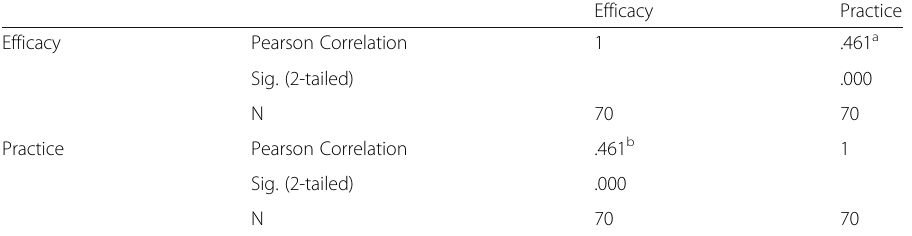
Table 2 Pearson Correlation Results for Self-efficacy and Instructional Practice